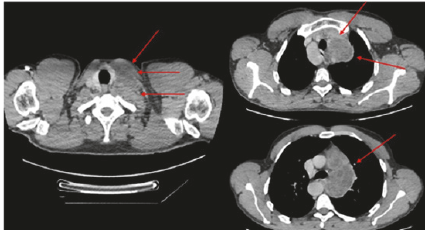
Figure 2: Chest tomography in axial section showing cervical and supraclavicular lymph nodes enlargement on the left. Left mediastinal masses with necrotic appearance (red